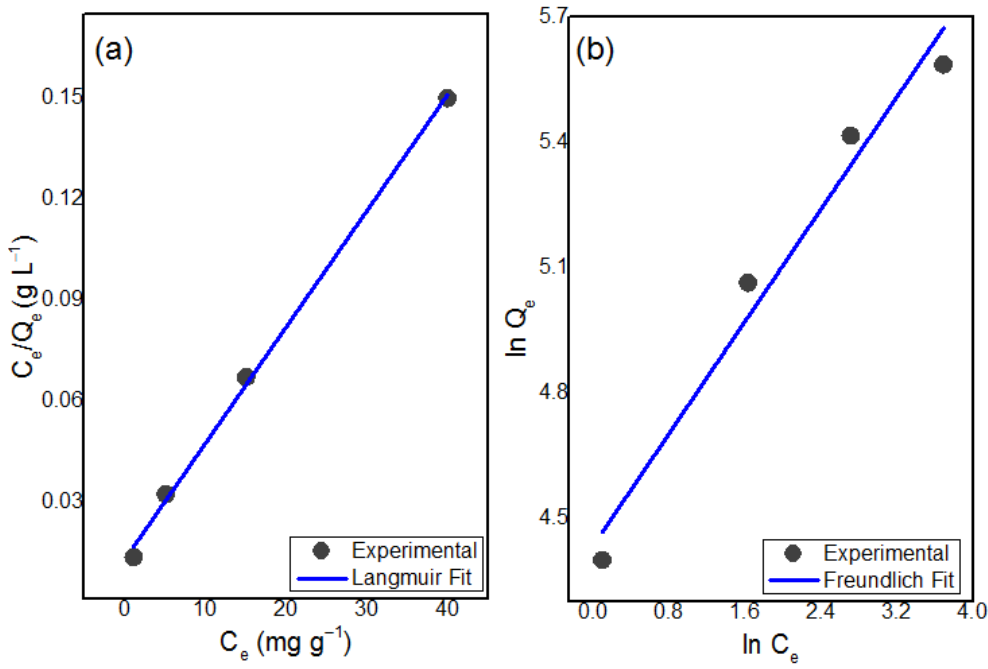
Figure 9. Isotherm model plots for MG adsorption onto AC@PIN composite ( a ) Langmuir and ( b ) Freundlich isotherms [AC@PIN = 6 mg; Temperature = 20 ◦ C; contact time = 60 min; pH = 10]. Table 2. Isotherm parameter values for adsorption of MG on AC@PIN composite at 20 ◦ C. Experimental Langmuir Isotherm Model Freundlich Isotherm